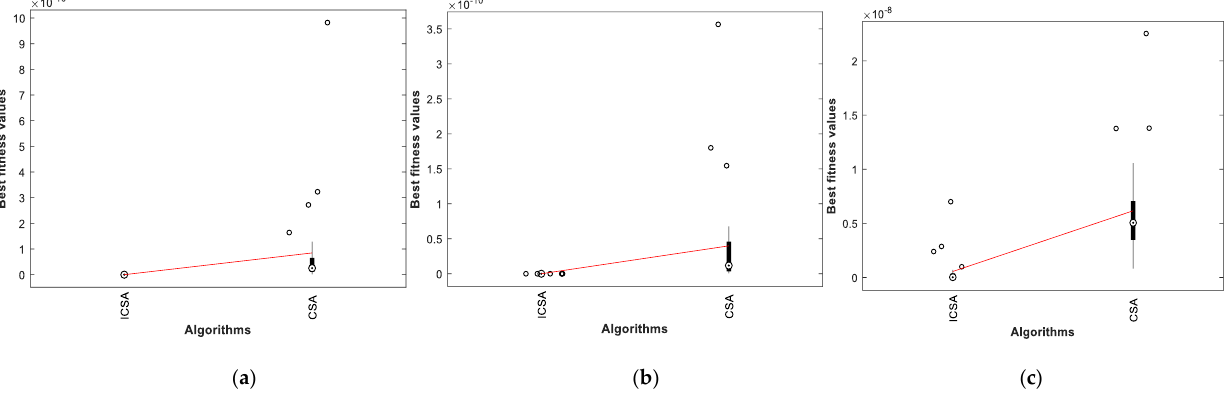
Figure 26. Boxplot of CSA and ICSA for various test cases : ( a ) Boxplot for F1; ( b ) Boxplot for F2; ( c ) Boxplot for F3.